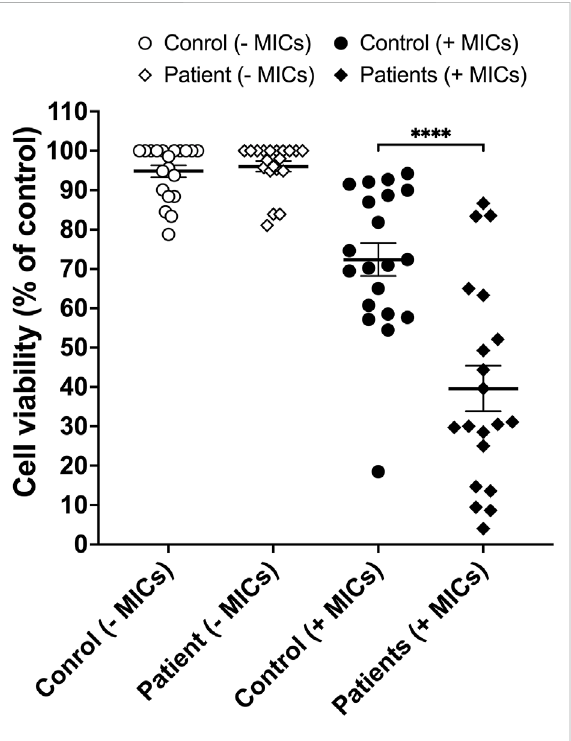
FIGURE 2 Cell viability (expressed as % of control) of PBMCs from healthy volunteers without microsomes (MICs, open circles), SSLR patients without MICs (open diamonds), healthy controls with MICs (closed circles) and SSLR patients with MICs (closed diamonds). Mean ± SEM. ****, p <